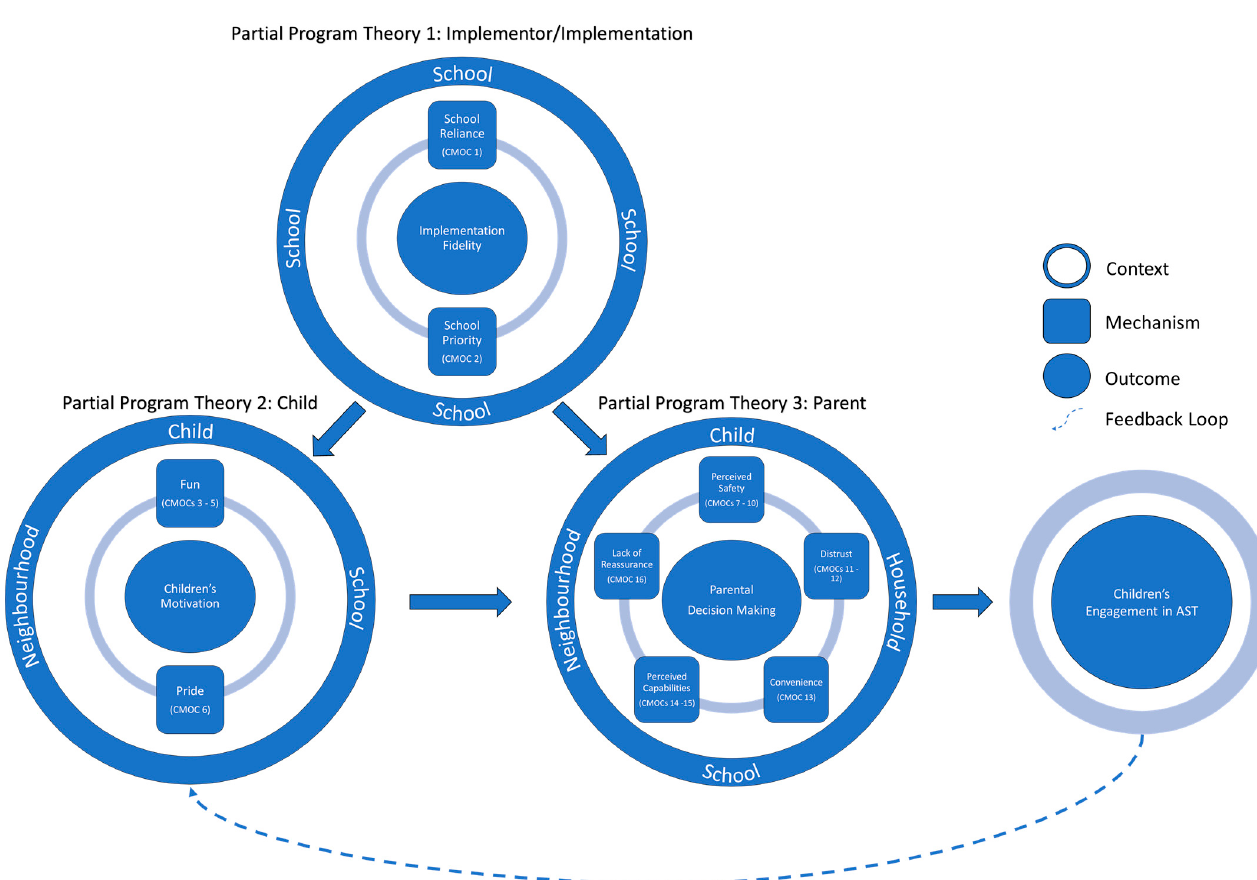
Figure 3. Overarching Program